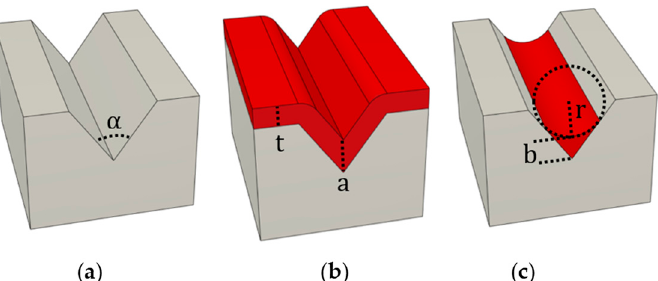
Figure 1. Schematic illustration of the basic principle of corner lithography: ( a ) nonflat substrate with a concave corner with angle α , ( b ) conformal deposition of material with thickness t and effective thickness a in the concave corner and ( c ) timed isotropic etching by amount r leaving a material with thickness b in the concave corner.